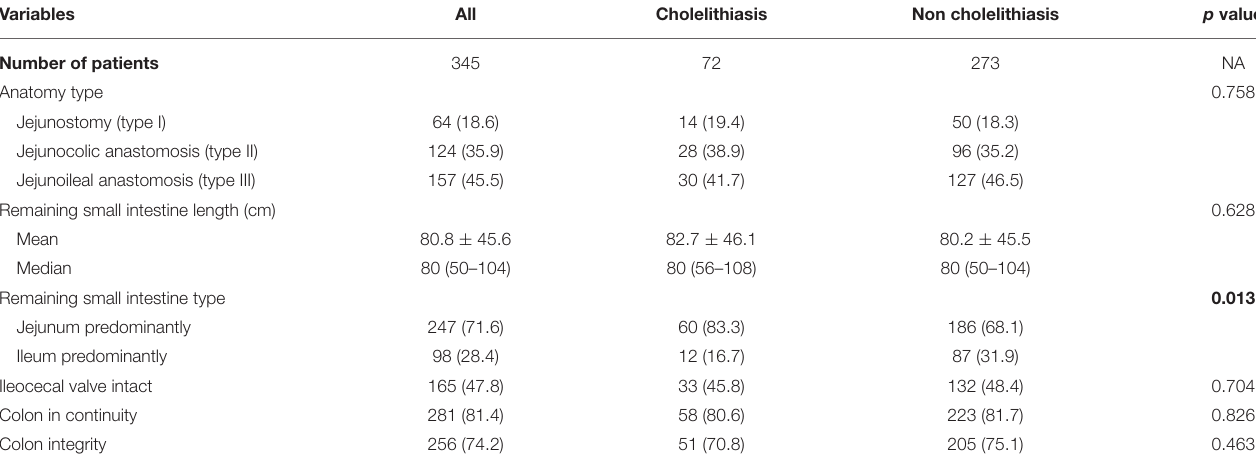
( Figure 2 ). The features of the entire study population stratified by the abdominal imaging diagnosis are detailed in Tables 1 – 3 . Cholelithiasis was present in 14 (19.4%) patients with end-jejunostomy without colon-in-continuity and 58 (80.6%) with jejuno-colonic or jejuno-ileal anastomosis and colon-in- continuity ( Table 3